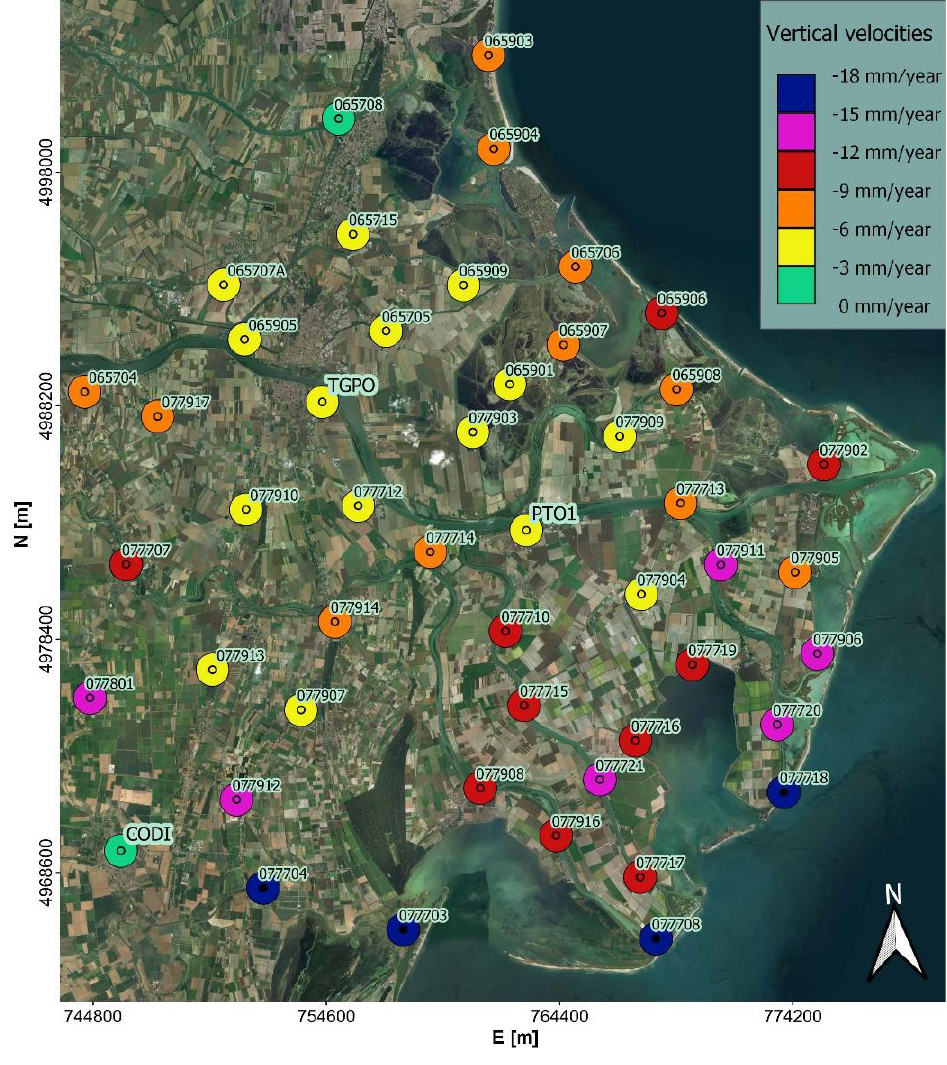
Figure 5. Vertical velocities of the PODELNET GNSS network obtained from the surveys performed in 2016, 2018, and 2020.